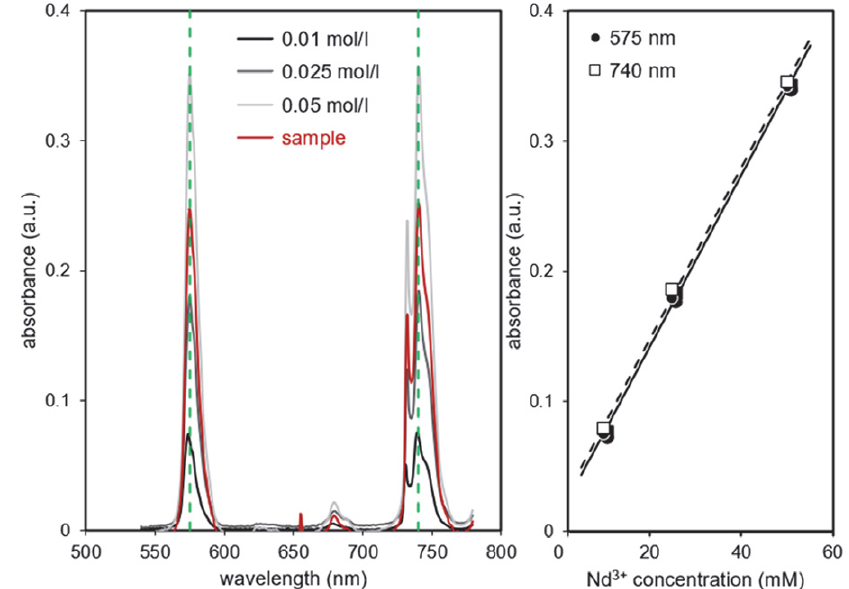
Figure 6: Absorbance spectra of Nd 3+ before and after adsorption on MNPs. The labels of spectra recorded after adsorption indicate the filter used for removing MNPs (pore size 20 nm, 200